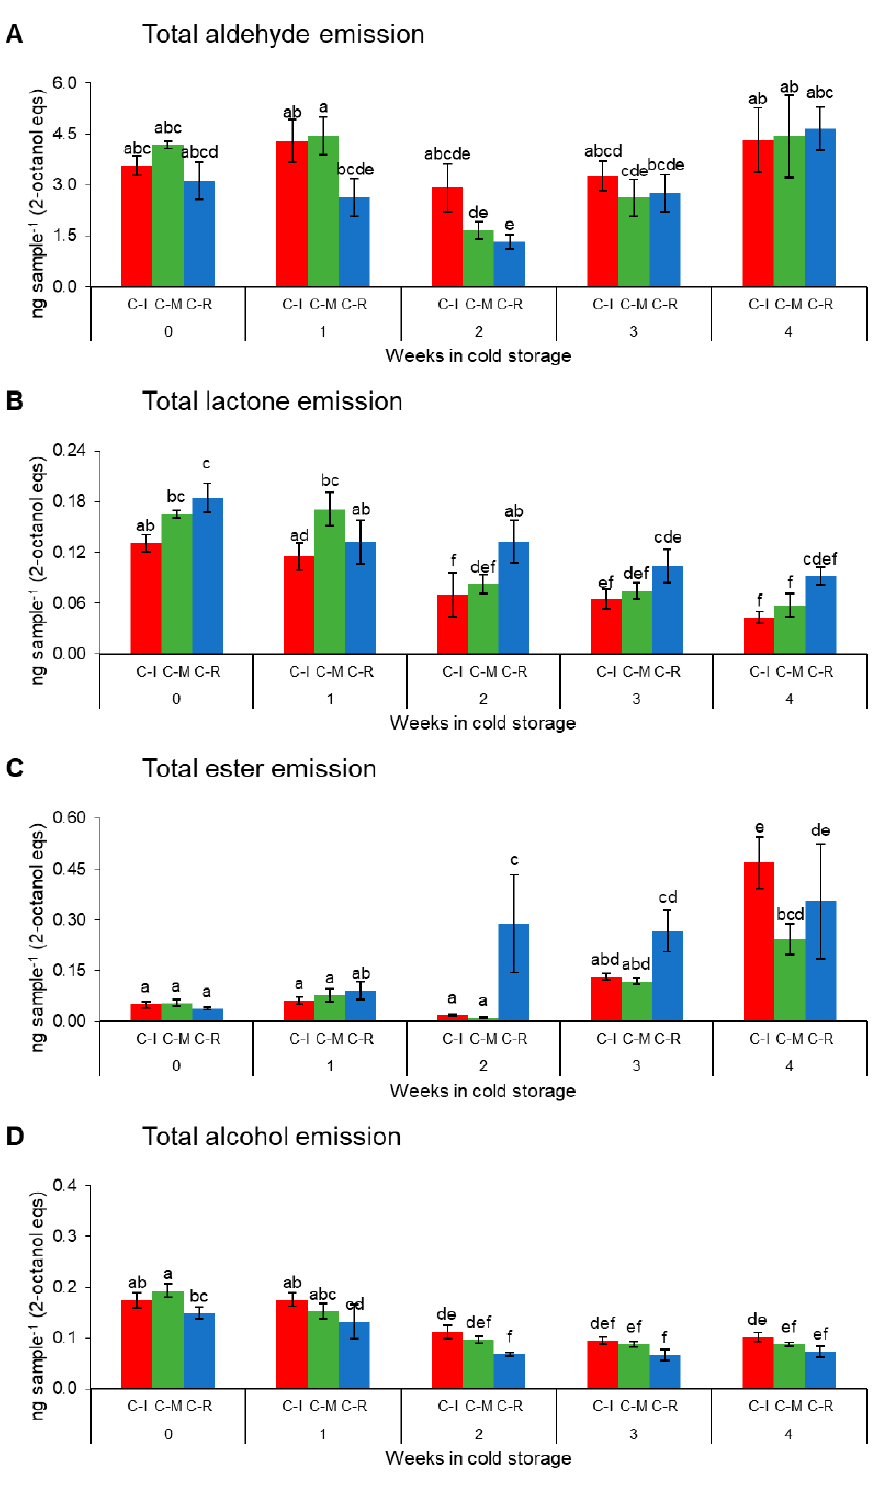
Figure 3. Emission of volatile compounds (grouped by chemical family and expressed as 2-octanol equivalents) from fruit samples collected at different maturity stages (C-I: immature; C-M: commercially mature; C-R: ripe), subjected to cold storage for 0–4 weeks, and measured at the beginning of shelf-life at room temperature. For each chemical family ( A : aldehyde; B : lactone; C : ester; D : alcohol), bars marked with different letters are significantly ( p < 0.05) different according to ANOVA followed by Fisher’s Least Significant Difference